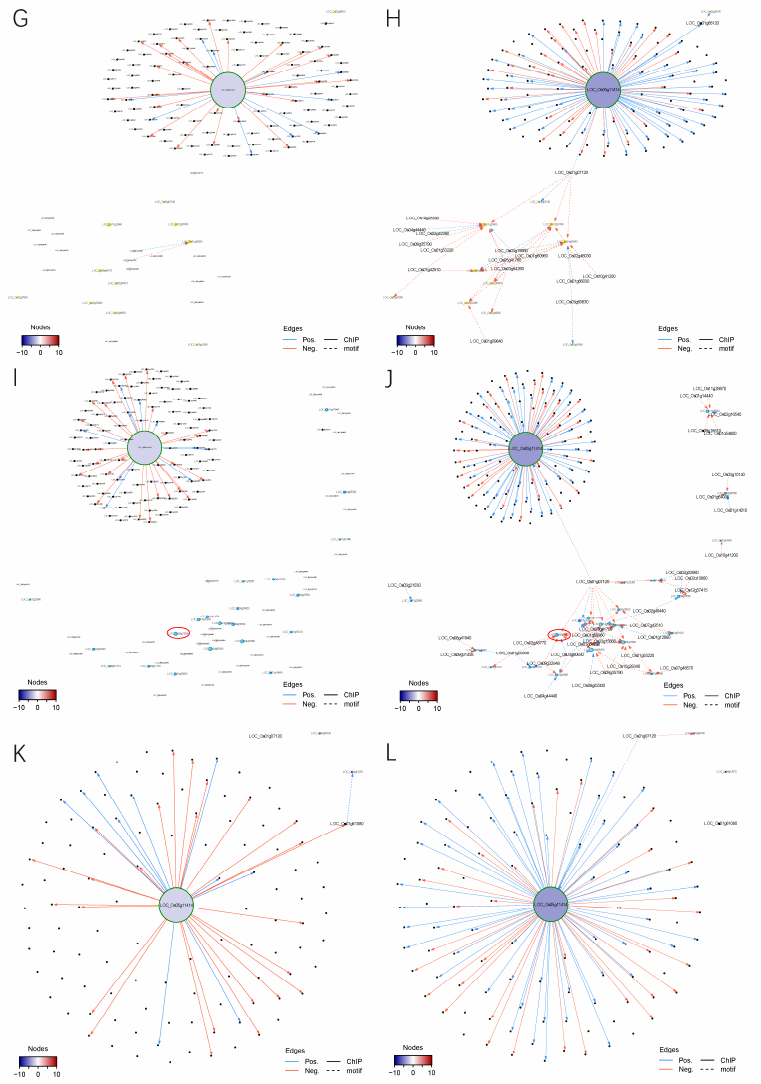
Figure 8. The sub-transcriptional regulatory network in different types of perturbation. ( A , B ) Tran- scriptional regulatory networks for the target genes of OsMADS58 in WT-dSpm ( A ) and WT-CRISPR ( B ) comparisons. Only the genes either differentially expressed in at least one comparison or directly targeted by OsMADS58 are shown. The node sizes indicate the number of neighborhoods for corre- sponding genes. OsMADS58 , OsMADS58 target genes, and oxidation reduction-related genes are highlighted by green, black, and orange circles, respectively. Gene IDs of transcription factors and oxidation reduction-related genes are shown with big and small text size, respectively. Nodes are colored according to high (red) or low expression (blue) related to wild-type (WT) samples. Grey nodes indicate non-differentially expressed genes. Edges denote regulation supported by ChIP-seq data (solid) or predicted by motif scanning (dashed). Only the edges with an absolute of correlation greater than 0.25 are shown. Edges are colored according to positive (blue) or negative (red) correlation between gene pairs. ( C – L ) Transcriptional regulatory networks for each pathway in WT-dSpm (left) and WT-CRISPR (right) comparisons. ( C , D ) Chloroplast development genes; ( E , F ) oxidation reduction genes; ( G , H ) cell cycle genes; ( I , J ) meiosis genes; ( K , L ) tapetum differentiation genes. Only the upstream and downstream genes of the pathway-related genes differentially expressed in at least one comparison are shown. High quality original files ( A – L ) can be found in the Supplementary